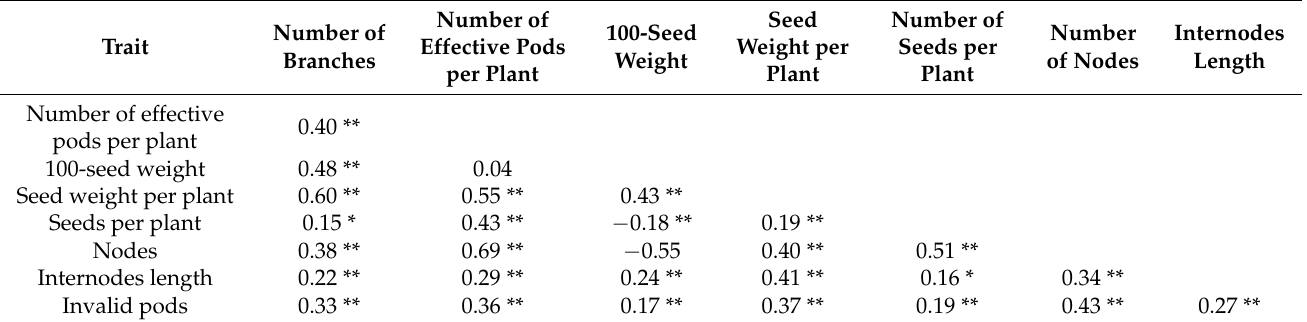
Table 8. The correlation coefficients among the agronomic traits in 242 wild soybean samples based on mean data in the years of 2012 and